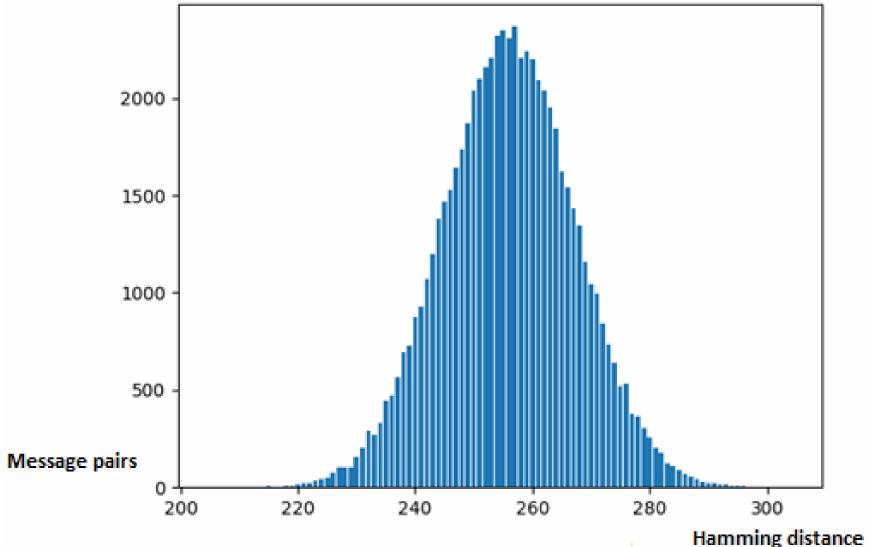
Figure 4. The avalanche effect of the hash function Nik-512.